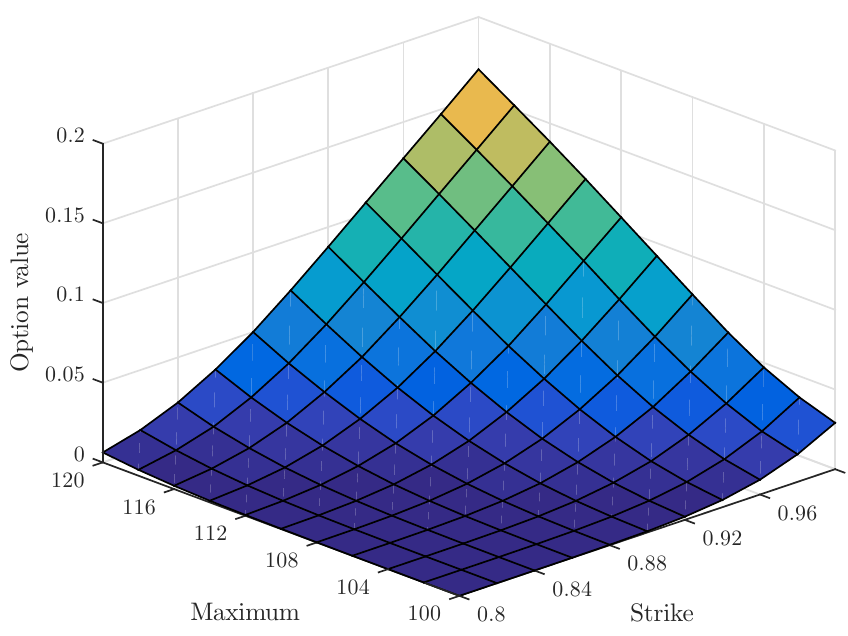
Figure 7. π -option on relative drawdown price estimations for varying K and M 0